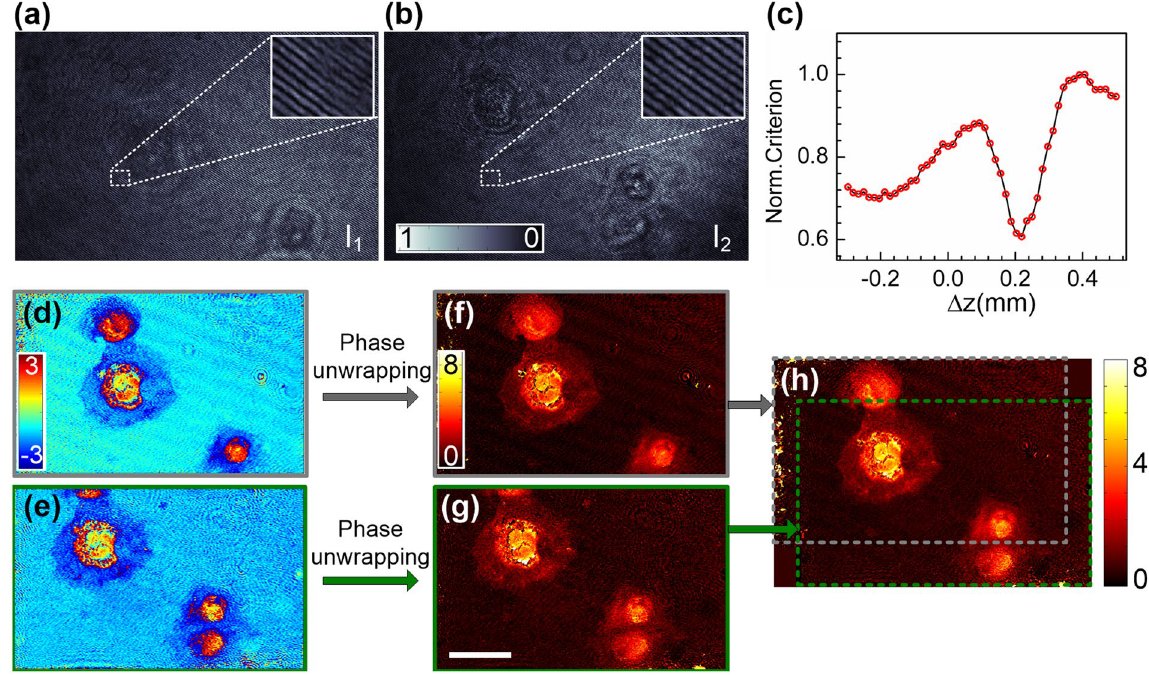
Figure 6. Extension of field of view (FOV) by OV-DHM. ( a ) and ( b ) opposite-view holograms of Cos7 cells (Sigma-Aldrich, St. Louis, MO); ( c ) criterion for image plane determination; ( d ) and ( e ) wrapped phase of O1 and O2; ( f ) and ( g ) unwrapped phases of O1 and O2; by using the Goldstein phase-unwrapping algorithm; 32 ( h ) combined phase image for field of view (FOV) extension. The phase value in ( f )–( h ) is reversed for a better display contrast. Scale bar in ( g ), 90 μ